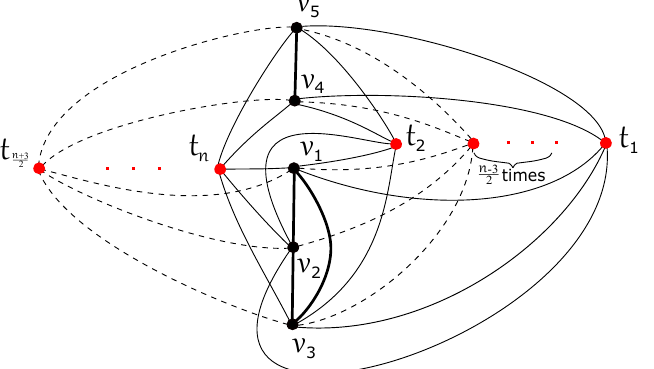
(cid:4) n (cid:5)(cid:4) n − 1 (cid:5) + (cid:4) n (cid:5) − 1 crossings for n odd, n ≥ 3, where 2 2 2